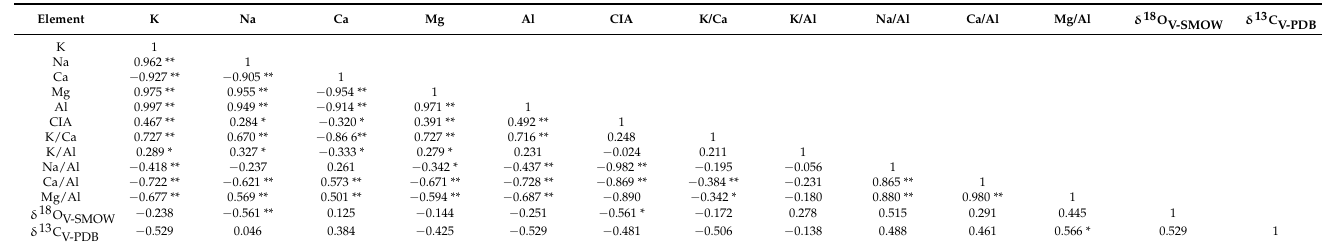
Figure 5. Element (Ca, K, Al, Na, Mg) composition content, element ratios (K/Ca, K/Al, Na/Al, Mg/Al, Ca/Al) and CIA value of calcareous tufa. The black dots indicate the location of the black peat layers. Table 3. Pearson correlation matrix of main elements, element ratios, and isotopes ( δ 13 C V-PDB and δ 18 O V-SMOW ) in the calcareous tufa